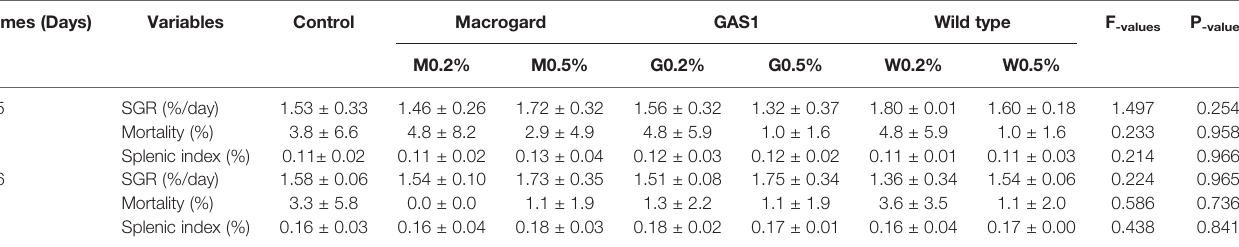
TABLE 3 | Mean ( ± SD) values for speci fi c growth rate (SGR), mortality and splenic index (SI) of trout juveniles fed with low (0.2%) and high (0.5%) doses of different beta glucan types on day 15 and day 36 of the feeding trial. Times (Days)